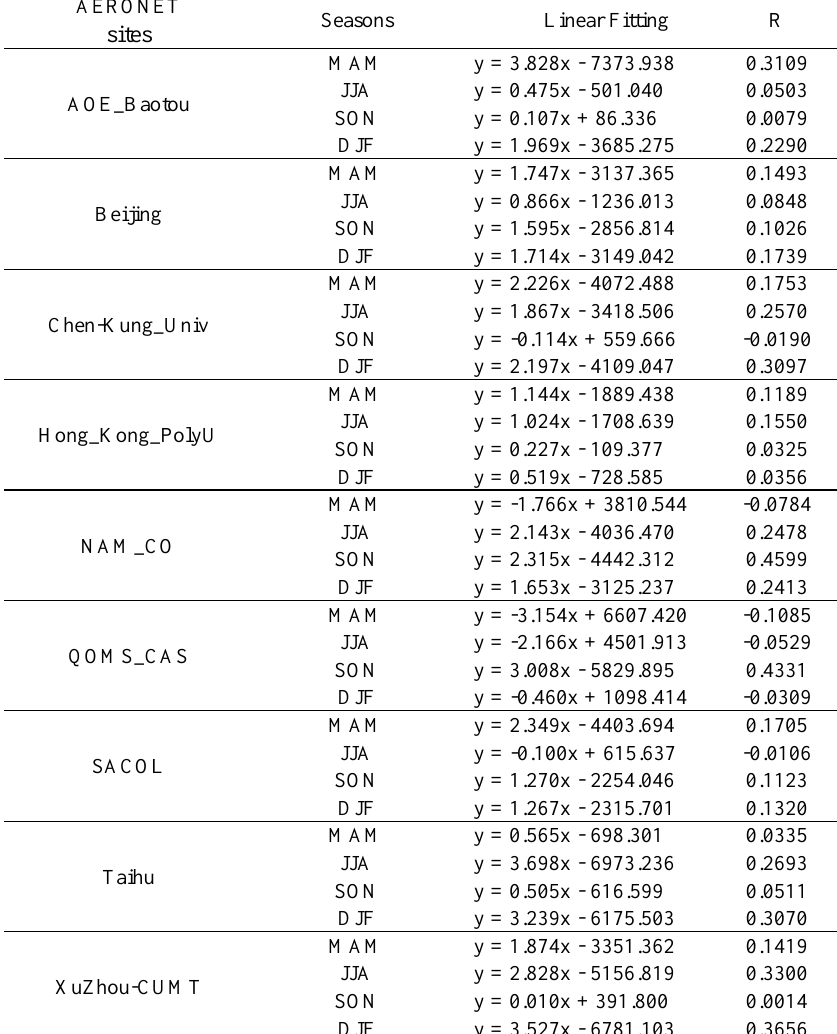
Table 3. Trend analysis of annual trop ozone column in different seasons from 2004 to 2017 at nine